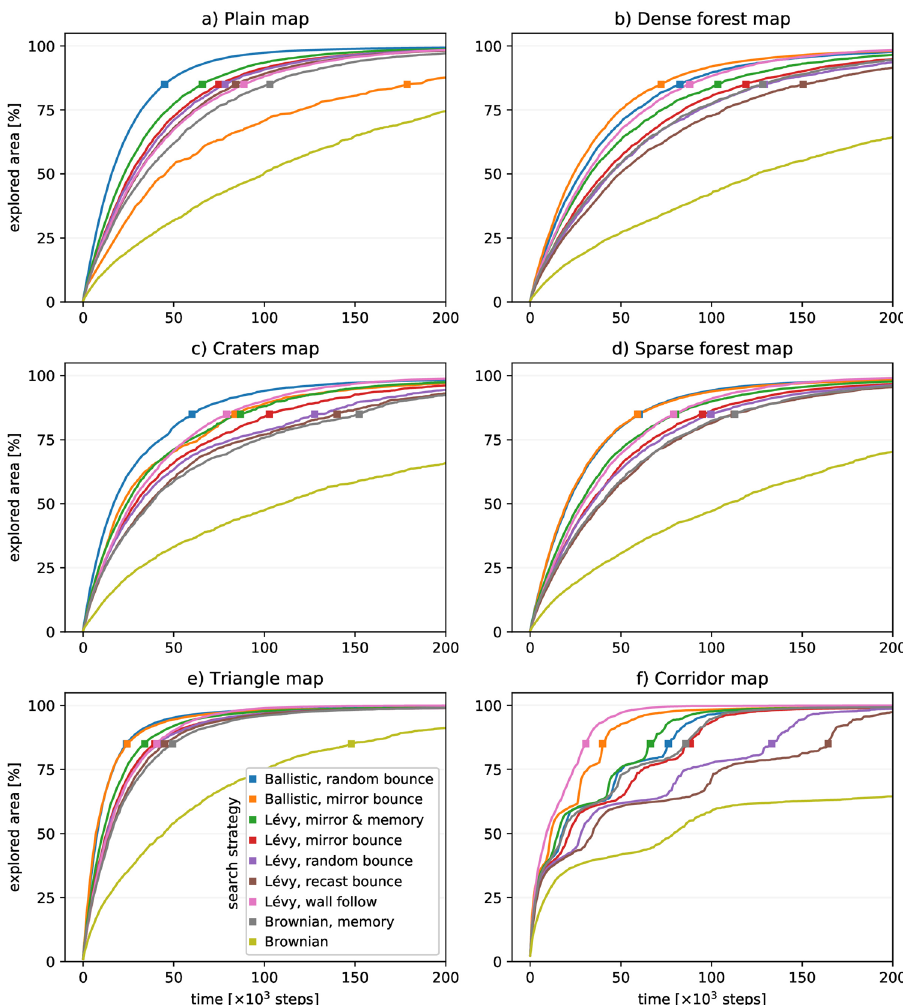
Figure 4. Exploration diffusivity represented as the area explored by each strategy over time. Each trace aggregates 1000 simulations by representing the minimum area covered by at least 900 of the runs at each point in time. A square marker highlights the point where each strategy covered 85% of the total available area (see Table 1 for the area